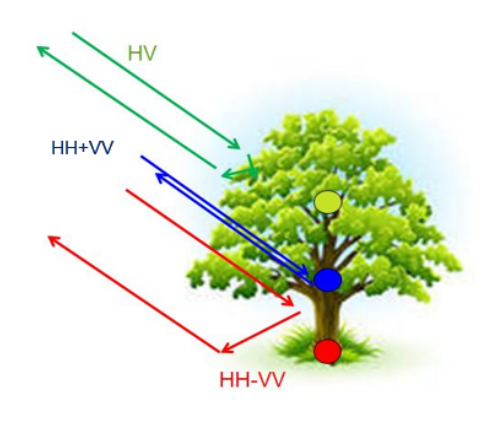
Figure 1. The three dominant microwave scattering mechanisms in forest